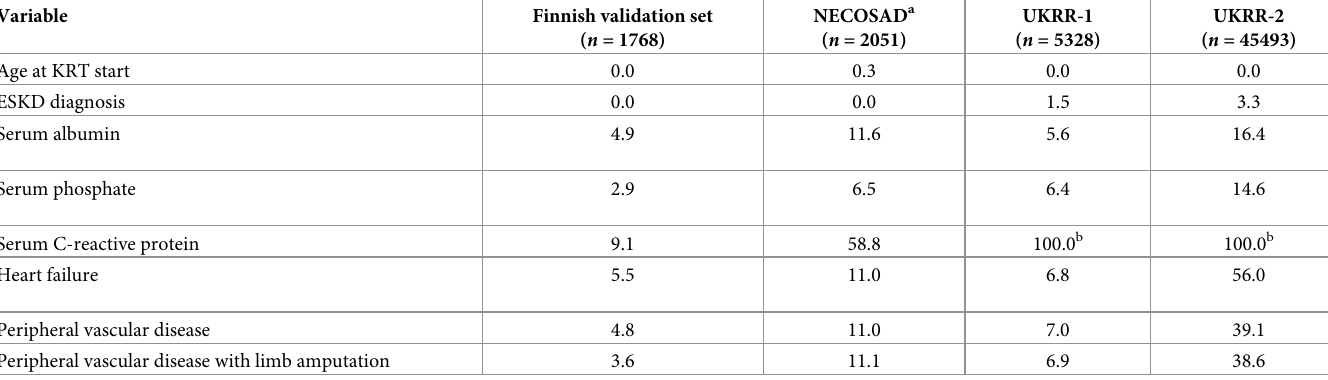
NECOSAD a UKRR-1 UKRR-2 ( n = 1768) ( n = 2051) ( n = 5328) ( n = 45493)